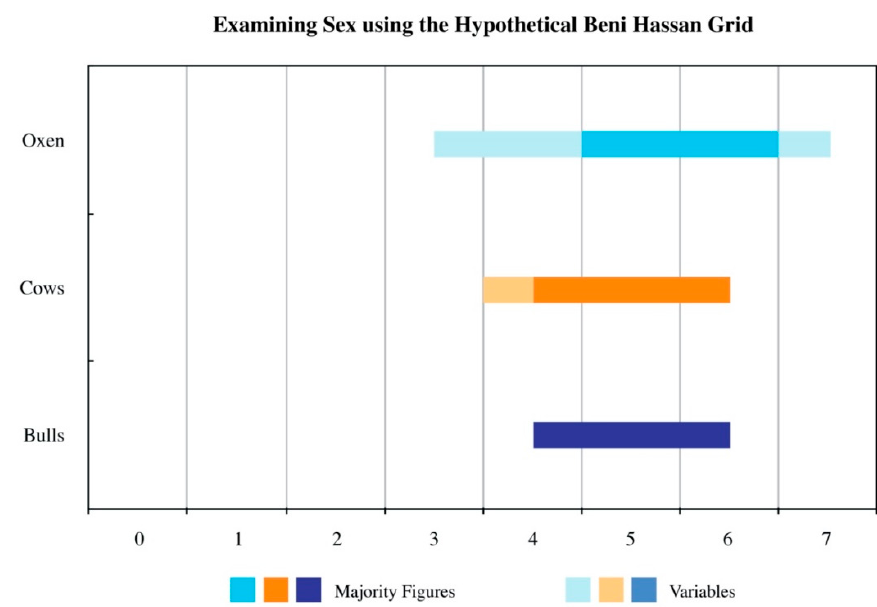
Figure 6. Examining sex using the hypothetical Beni Hassan